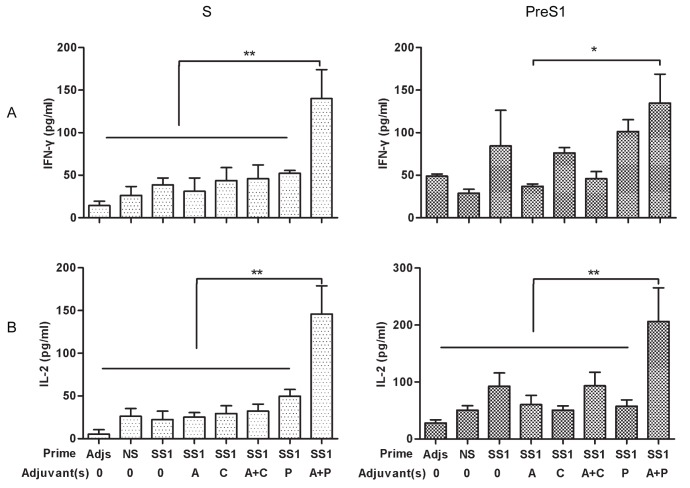
In vitro cytokine production by splenocytes from immunized mice after rAdSS1 boosting.(A) IFN-γ; (B) IL-2. Supernatants were collected at 48h after HBV S and PreS1 peptide pool stimulation and cytokines were quantified by ELISA. IFN-γand IL-2 were detected and data were shown as means±SEMs. Statistical differences between groups were determined, and differences are shown as *p<0.05 and **p<0.01. SS1: HBSS1 A, alum; C, CpG; P, poly(I:C). Adjs: control group with adjuvants mixture.